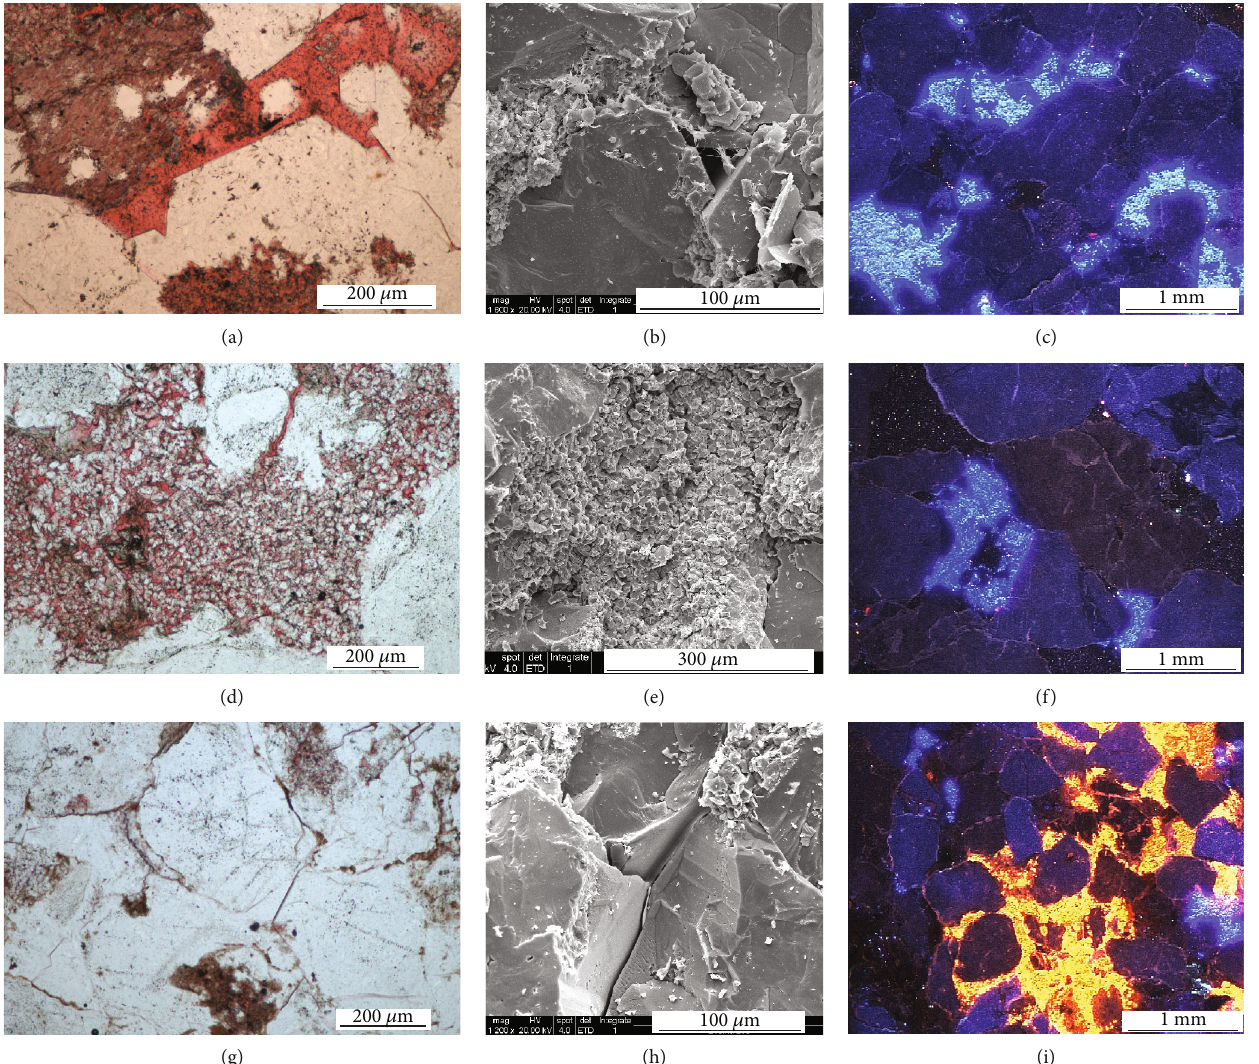
Figure 2: Casting section (a, d, g), SEM (b, e, h), and CL (c, f, i) images of the three typical